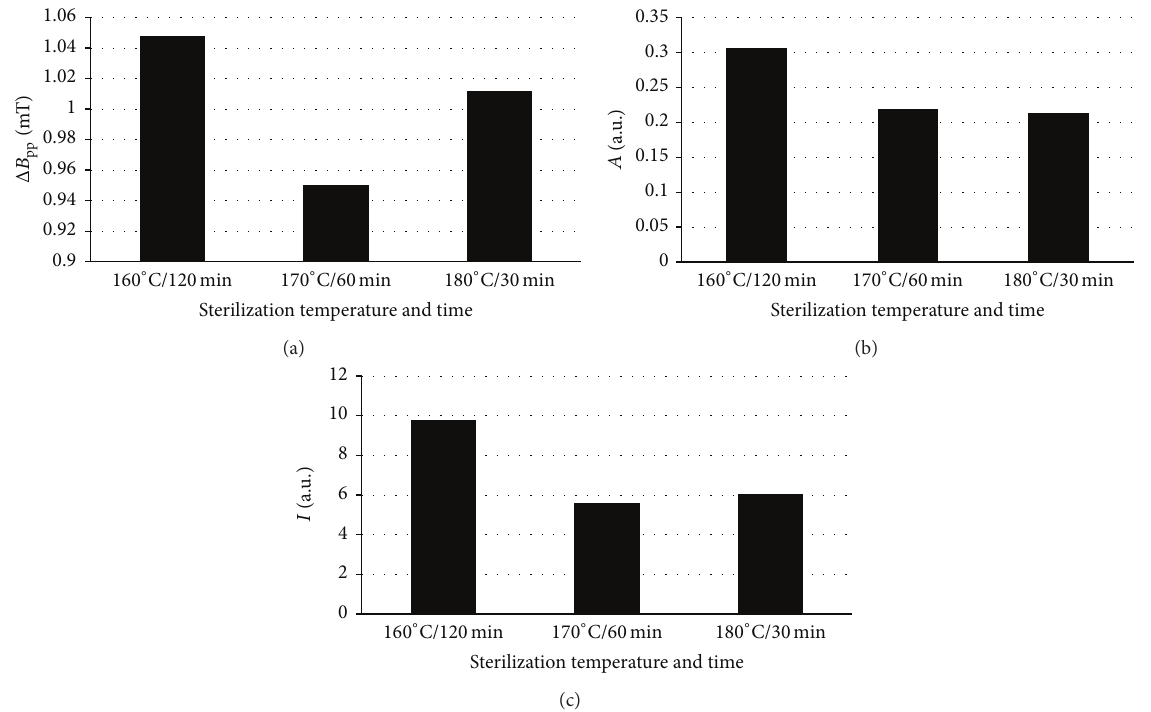
Figure 5: The parameters of the EPR spectra bismuth subgallate thermally sterilized at 160 ∘ C (120 minutes), 170 ∘ C (60 minutes), and 180 ∘ C ), (b) amplitudes ( 𝐴 ), and (c) integral intensities ( 𝐼 ). The comparison was done for the spectra measured (30 minutes): (a) line widths ( Δ𝐵 pp with attenuation of 15dB.